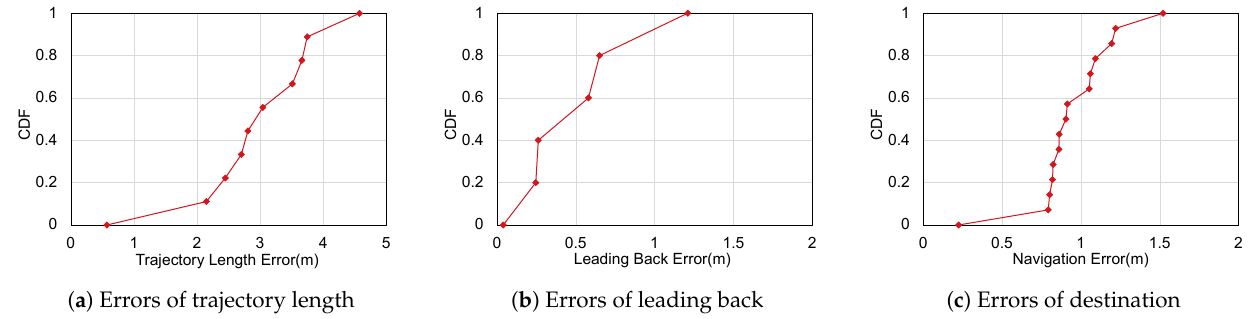
Figure 16. ( a ) is the errors of trajectory length with dynamic step length. ( b ) is the errors of leading back. ( c ) is the errors of destination.